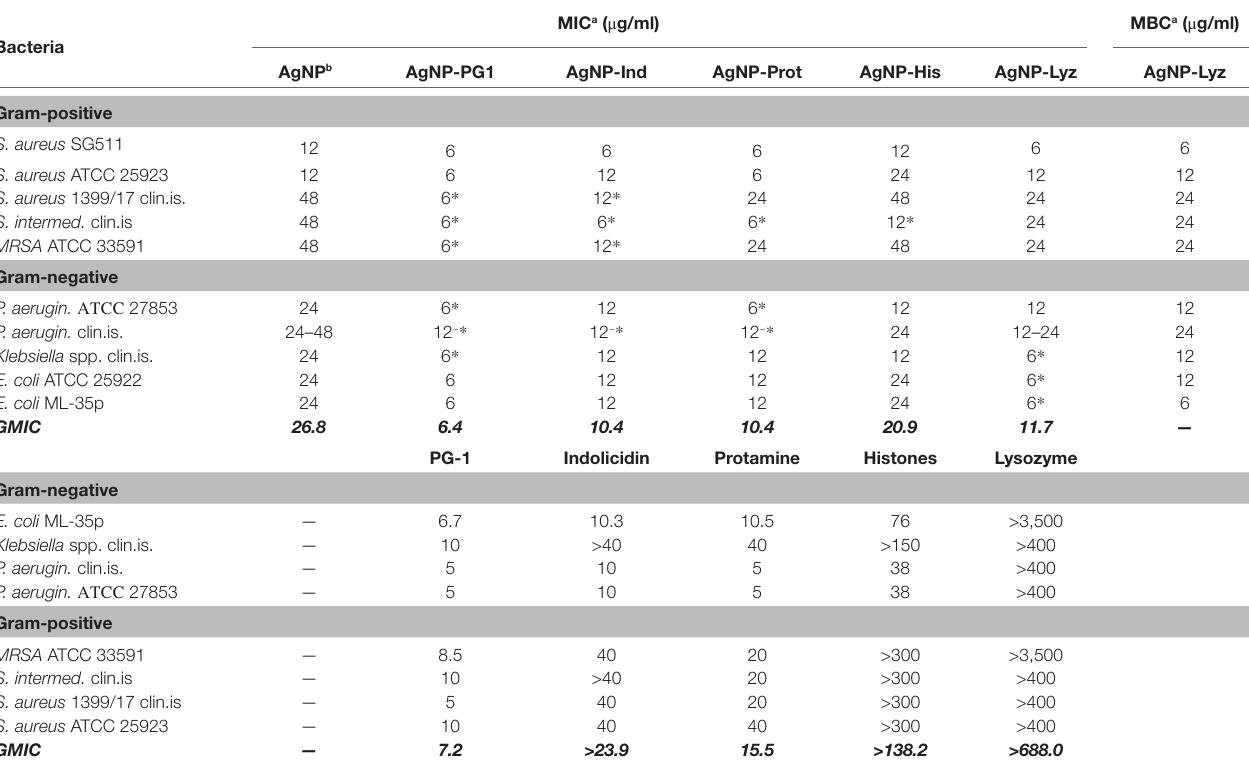
TABLE 2 | Antimicrobial activity of silver nanoparticle conjugates with antimicrobial peptides or proteins.